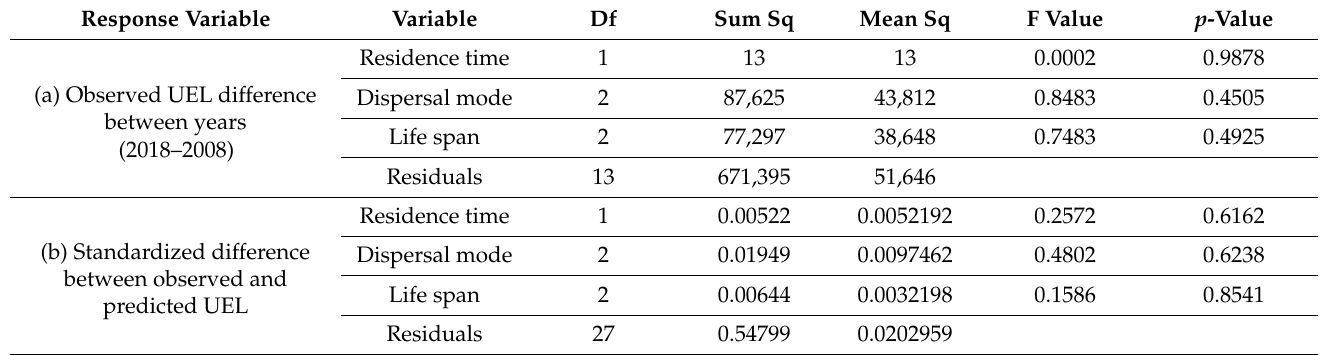
Table 1. ANOVA test results for the relations between residence time, dispersal mode (animal, wind or unassisted) and life span (annual, biennial or perennial) with two response variables: (a) observed UEL difference from 2018–2008 and (b) standardized difference between the observed and predicted UEL. Response